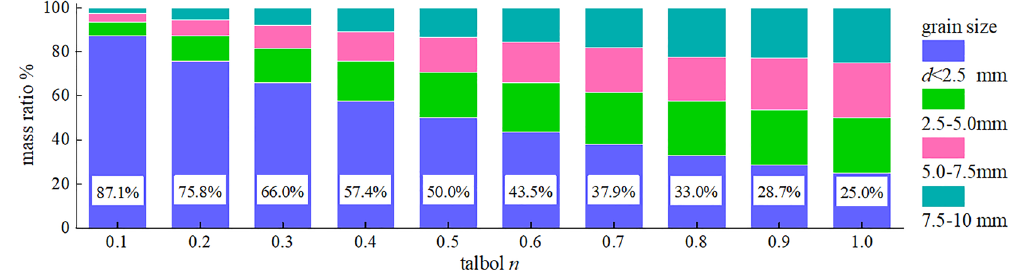
Figure 1. The ratio of particle size in the sample.